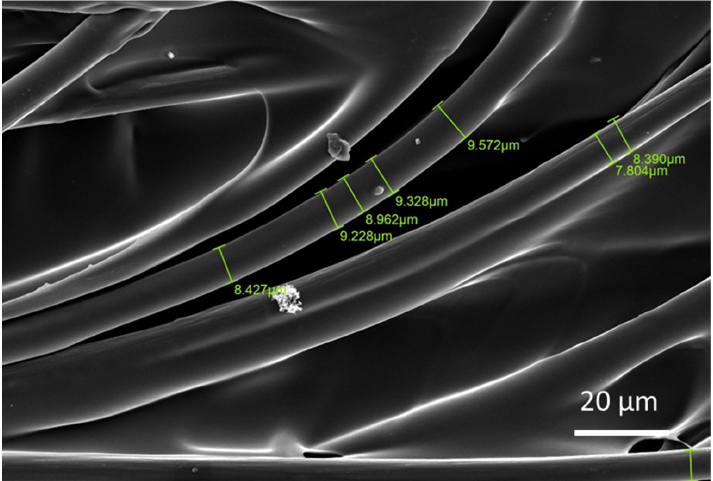
Figure 11. SEM micrograph of through-thickness samples showing fibre diameter and voids. Materials 2022 , 15 , x FOR PEER REVIEW